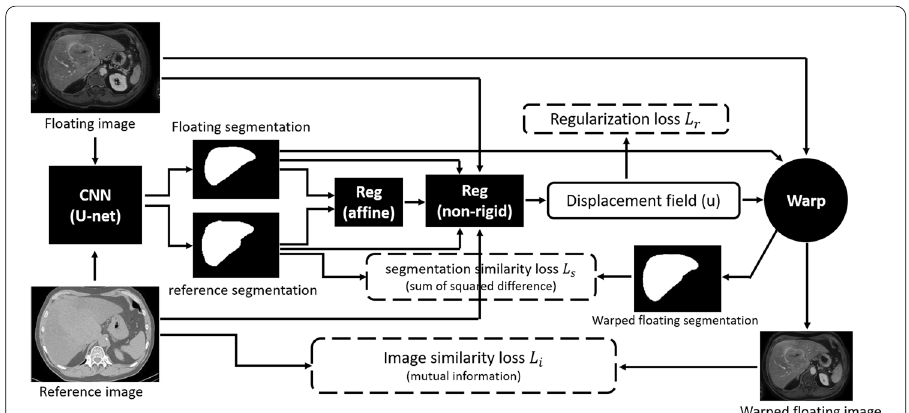
Fig. 4 Overview of the registration algorithm guided by CNN liver